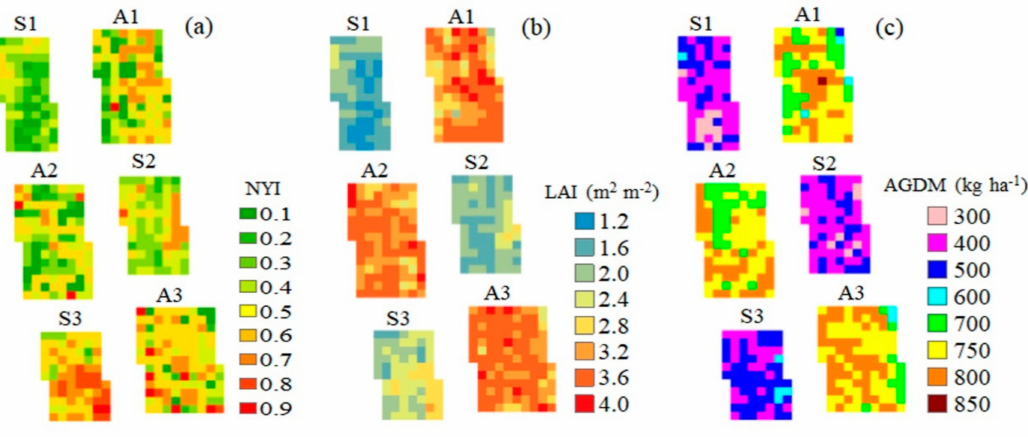
Figure 9. Two-dimensional field variations in the simulated barley variables of normalized yield index, NYI ( a ), leaf area index, LAI ( b ), and above ground dry mass, AGDM ( c ) at 60 days after rejuvenation in autumn (A) and spring (S) at Gyeongsang National University, Jinju, South Korea in